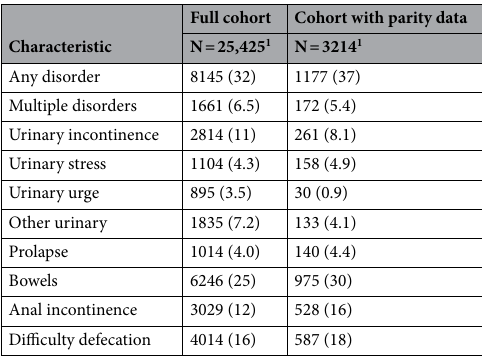
Table 2. Prevalence of pelvic floor disorders. 1 n (%).